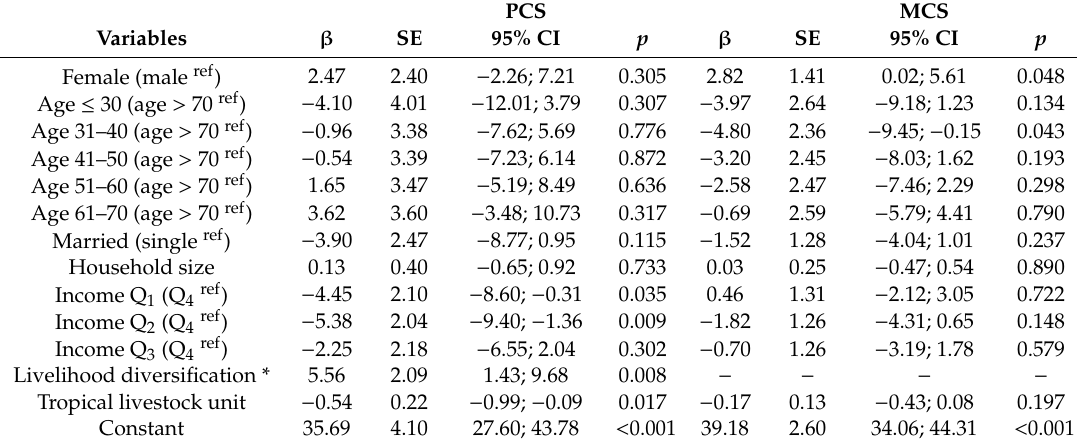
Table 3. Models for estimation of factors influencing general physical and mental